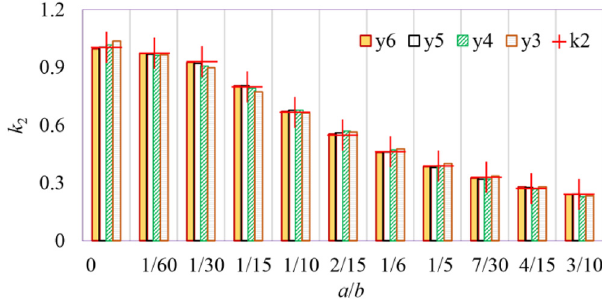
Fig. 18. The fi tting reduction coef fi cient k 1 of the square plate with square hole.